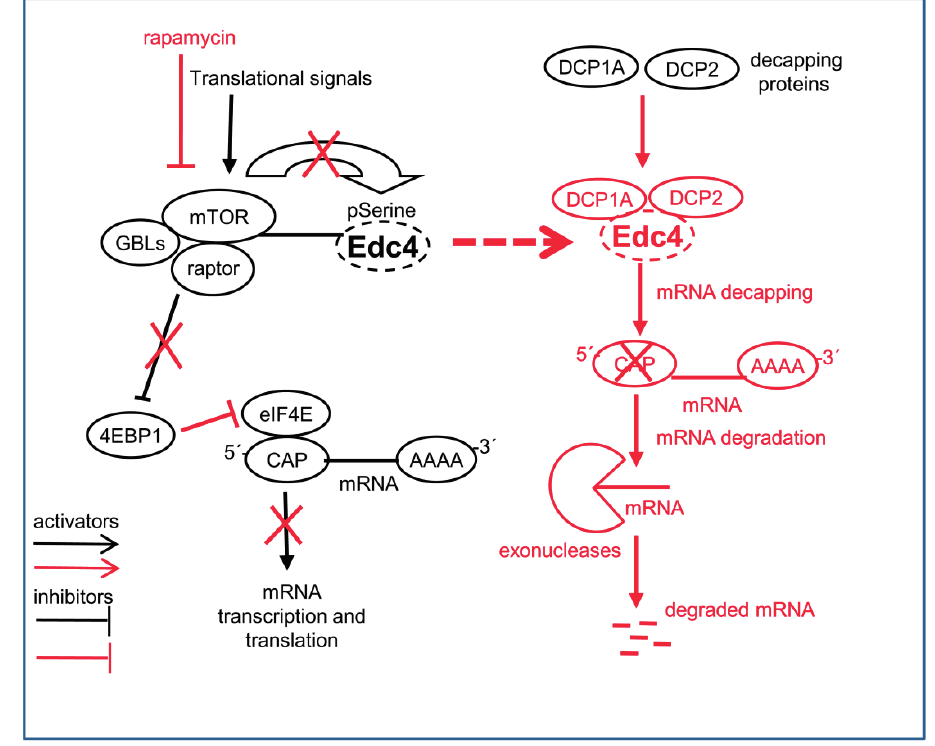
Figure 8. mTORC1 interplay in mRNA decapping through interaction with Edc4: The schematic diagram (Edc4 box) shows that mTORC1 interacted with Edc4 to keep its expression at the basal level by inhibiting Edc4 through serine phosphorylation (white bold arrow). This hyper-phosphorylated Edc4 was then no longer available for mRNA decapping activity in the mRNA decay process. Treatment of cells with rapamycin led to the inhibition of mTORC1 kinase activity, resulting in Edc4 dephosphorylation. This dephosphorylated Edc4 probably leads to activation of the decapping machinery and increased mRNA